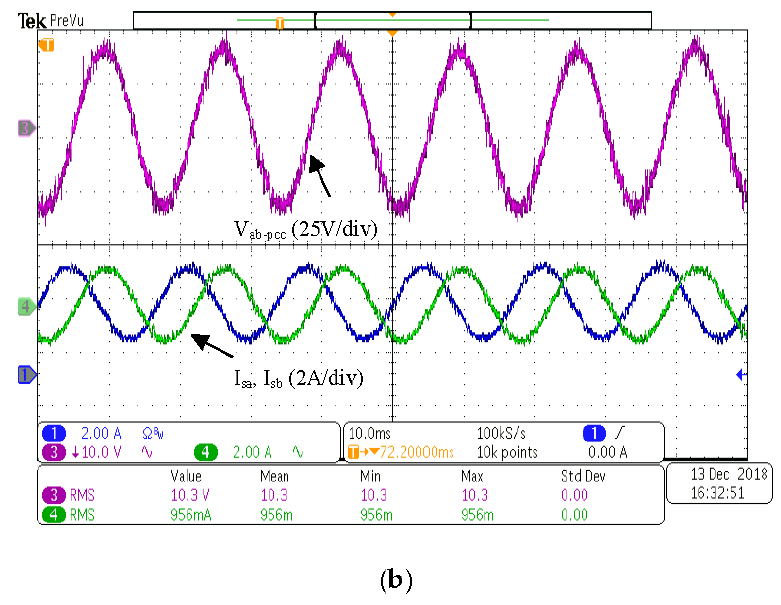
Figure 9. ( a ) v ab-pcc , i sa and i sb without the shunt APF. ( b ) v ab-pcc , i sa and i sb with the shunt APF. (10 ms/div).